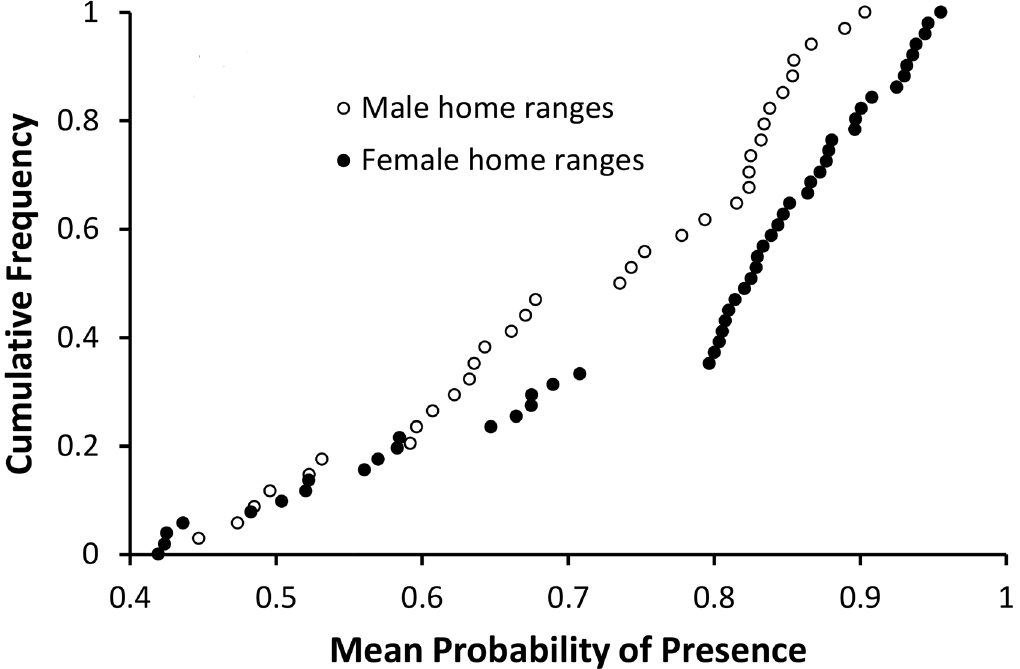
Fig 6. Average probability of presence in Florida panther home ranges. Males (open circles): median = 0.74, n = 35; females (solid circles): median = 0.82, n = 52. One male home range (average P = 0.35) is not shown.